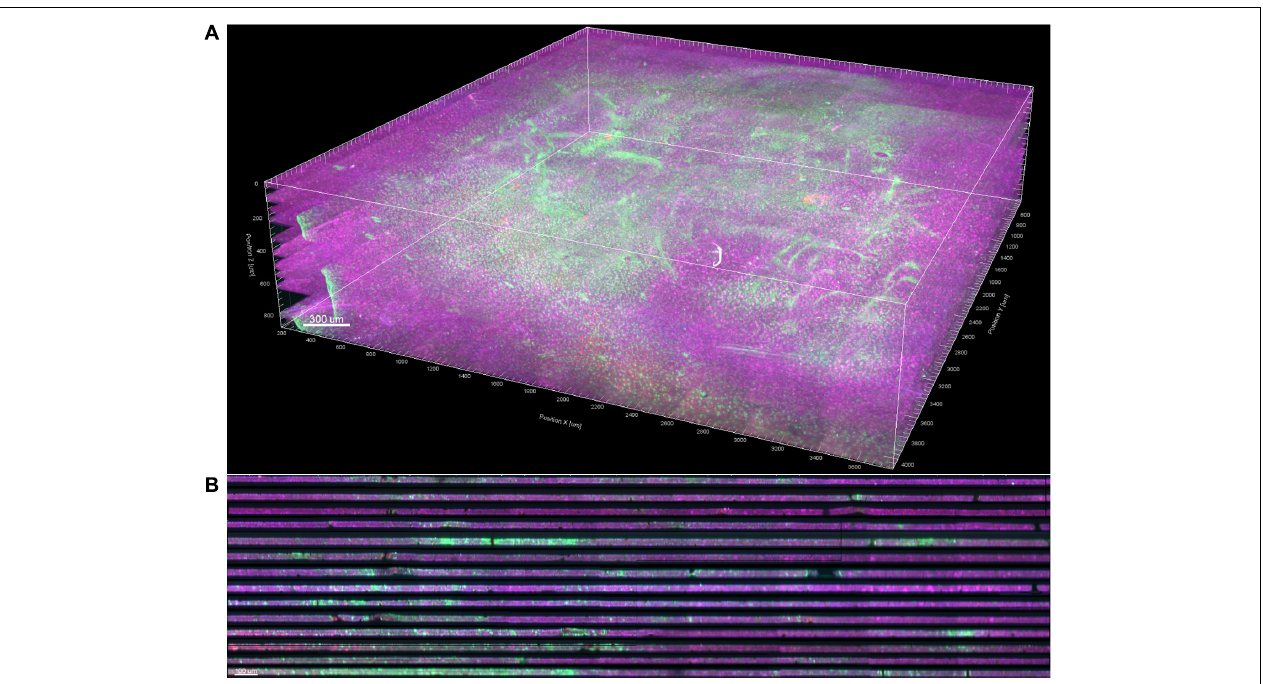
FIGURE 3 | (A) 3D volume rendering of GFAP (green) and NeuN (magenta) after stitching, cropping, and stacking. Dewarping, alignment, and intensity normalization have not yet been performed. (B) Vertical cross section through the 3D volume. The dark bands are dark, out-of-focus optical slices above and below the actual tissue in each